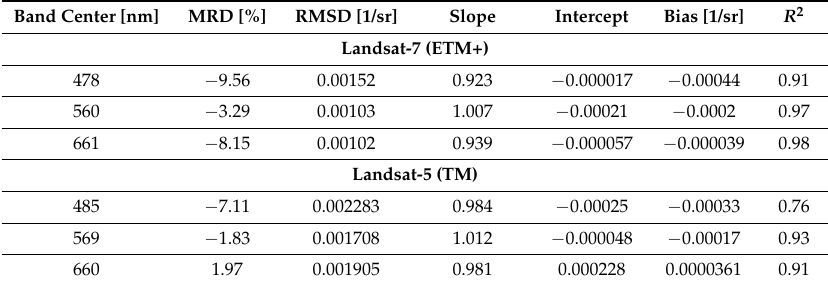
Table 5. The statistics associated with TM-MODIS ( n = 274) and MODIS-ETM+ ( n = 249) over select sites across North America. Uncertainties associated with the intercomparisons are attributed to atmospheric correction and spectral band